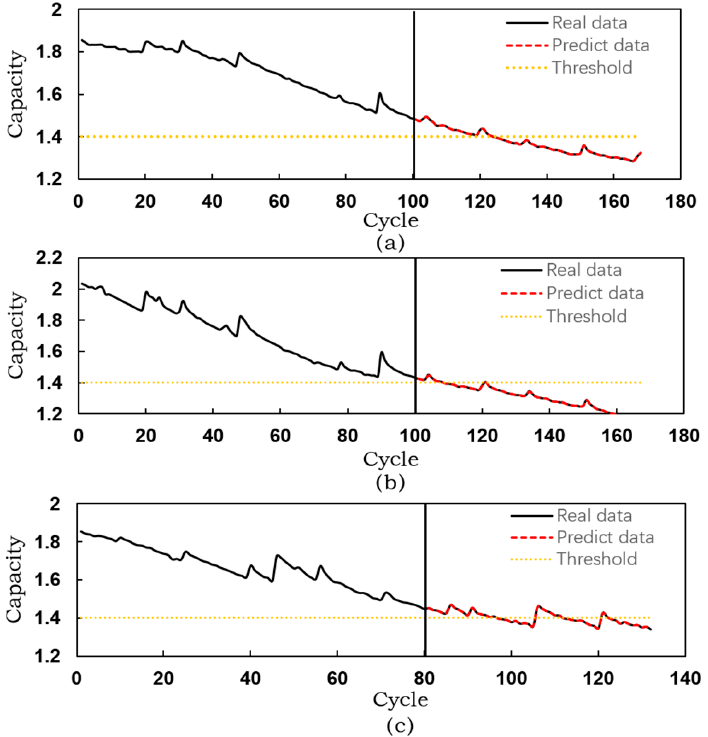
Figure 9. Prediction results for B0005 and B0006 with 100 . training samples and B0018 with 80 train- ing samples. ( a ) B0005, ( b ) B0006, and ( c ) B0018.